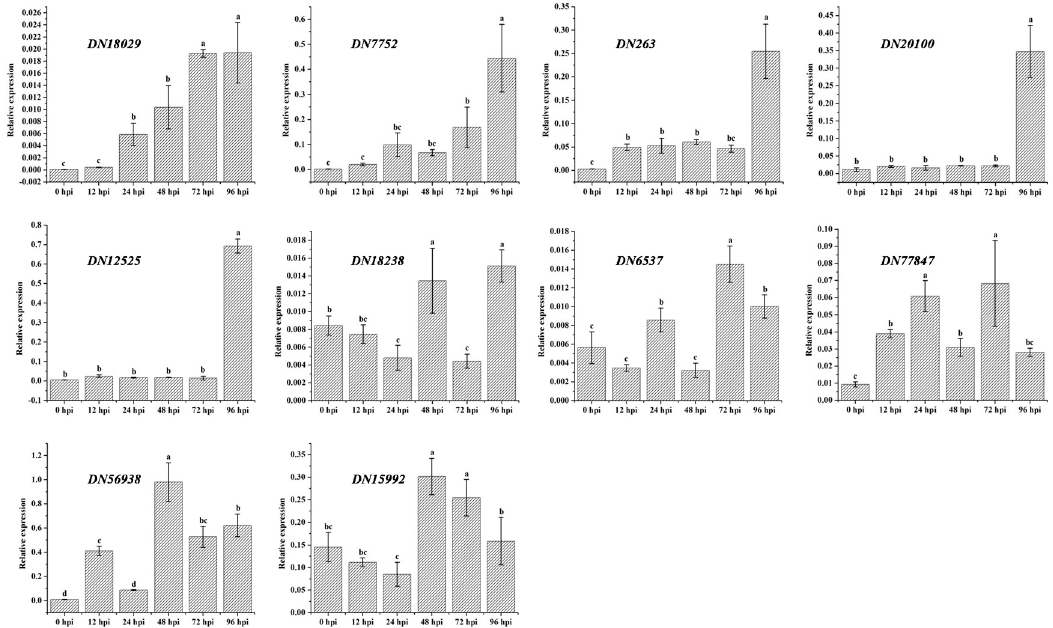
Figure 7. Expression levels of ten F. proliferatum candidate effector genes at six different time points (0, 12, 24, 48, 72 and 96 hpi) as determined by qRT–PCR analyses. The β -tubulin and ubiquitin genes were used as two internal control genes for normalization.